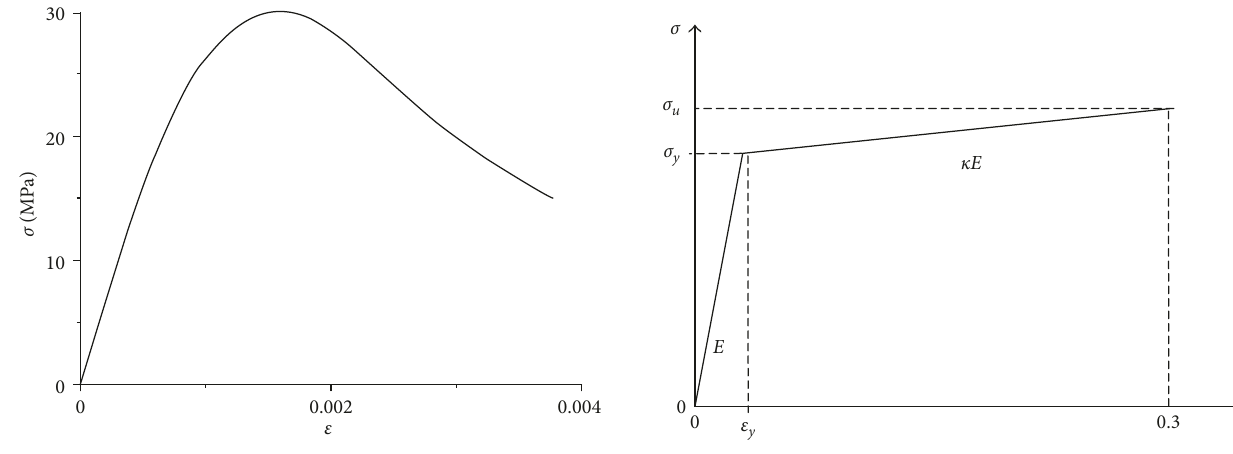
Figure 4: Concrete stress-strain curve. Figure 5: Constitutive relations of steel. Table 1: Mechanical behavior of